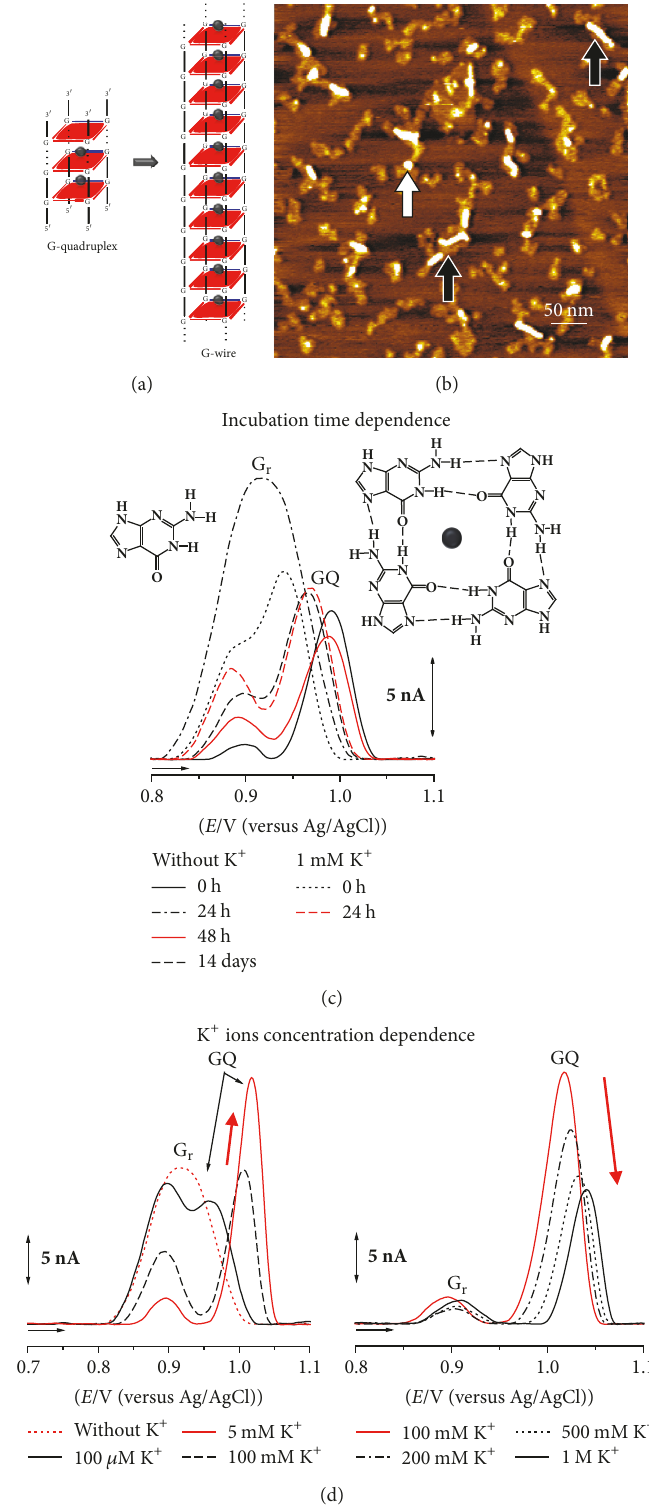
Figure 2: (a) Representation of d(G) 10 -GQ and GQ-based nanowire; (b) AFM image of 0.3 𝜇 M d(G) 10 in pH 7.0, 100mM K + ions, at 24 h incubation; (c, d) DP voltammograms baseline corrected in 3.0 𝜇 M d(G) 10 in pH 7.0: (c) incubation time dependence and (d) K + ions concentration dependence at 0 h incubation. [Adapted from [50] with